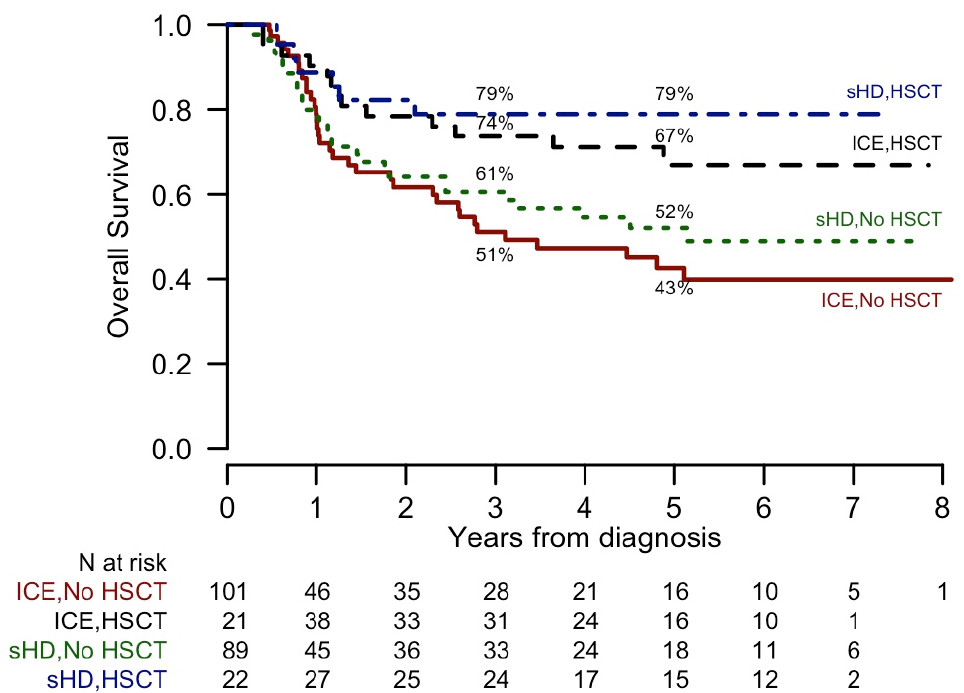
Figure 1. Kaplan-Meier curves of Overall Survival (OS), according to induction and consolidation treatments, in complete remission patients. 5-year OS estimates are reported. p values assessed comparing groups are: HSCT, sHD vs. ICE: p = 0.48; No HSCT, sHD vs. ICE: p = 0.52; sHD, HSCT vs. no HSCT: p = 0.03; ICE, HSCT vs. no HSCT: p = 0.01.